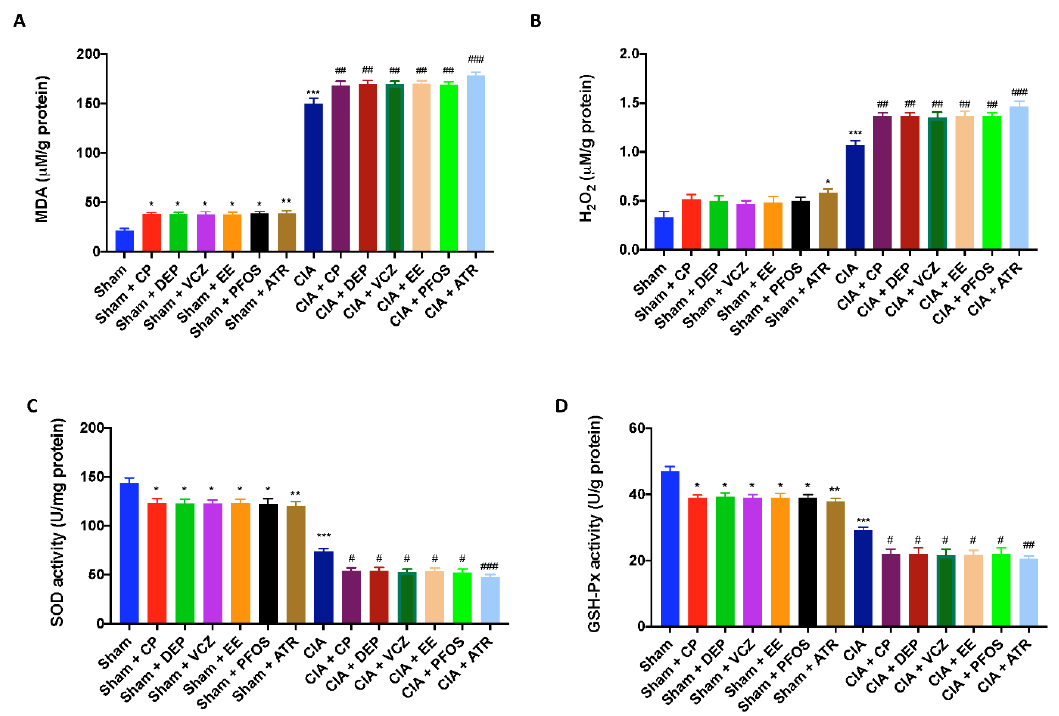
Figure 9. Levels of MDA ( A ); H2O2 ( B ); SOD ( C ); GSH-Px ( D ). * p < 0.05 vs. sham; ** p < 0.01 vs. sham; *** p < 0.001 vs. sham; # p < 0.05 vs. CIA; ## p < 0.01 vs. CIA; ### p < 0.001 vs.